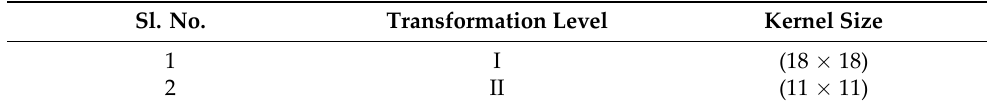
Table 2. Kernel size of the Bior‑1.3 wavelet.